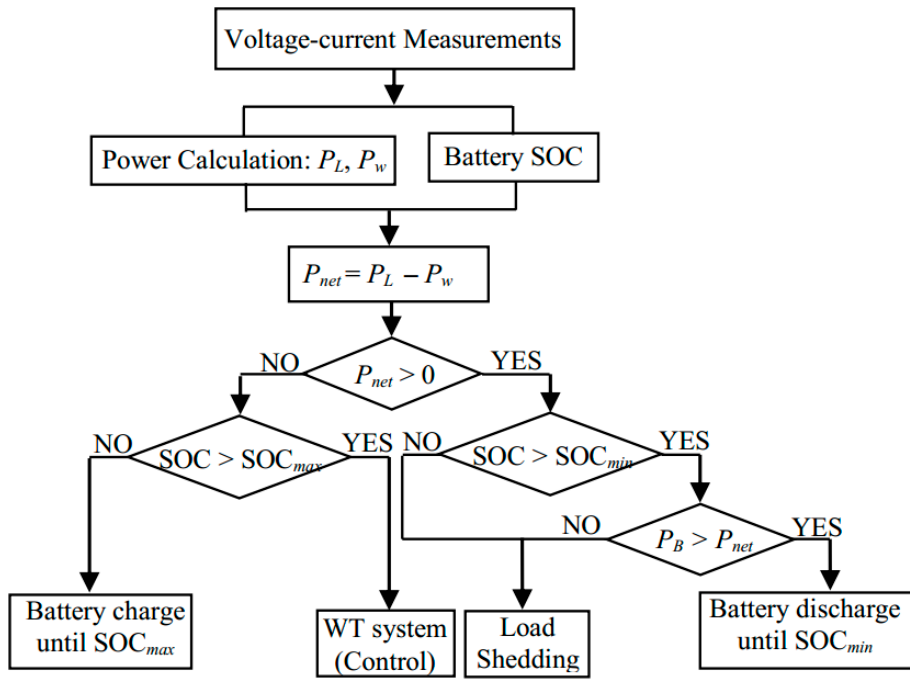
Figure 6. Flowchart of the power management system.